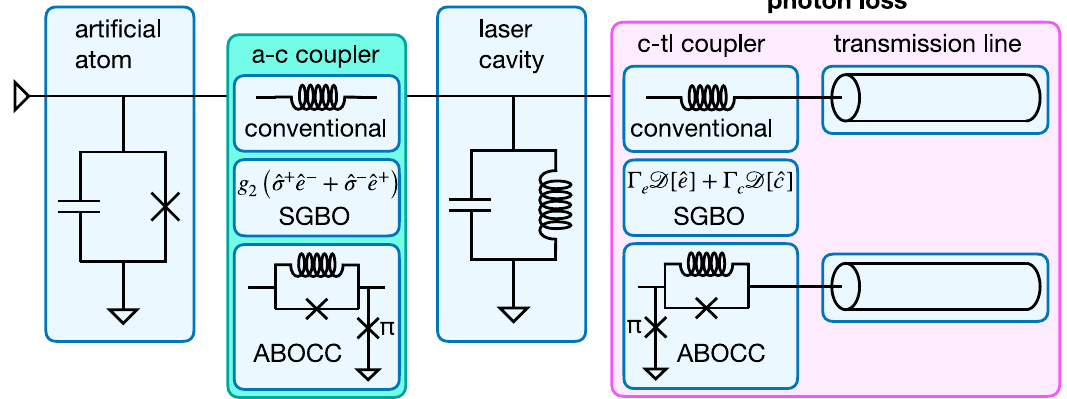
Fig. 1 Schematic of the superconducting Josephson laser. The laser is composed of: an arti fi cial two-level atom (transmon qubit) that is incoherently pumped from the ground to the excited state at the rate Γ p , an atom-cavity (a-c) coupling circuit, a laser cavity made of an LC resonator, a cavity- transmission line (c-tl) coupling circuit, and an output transmission line. The coupling circuits come in three fl avors: (1) conventional: linear inductors, (2) Susskind – Glogower bare operator (SGBO) couplers, and (3) Approximate Bare Operator Coupling Circuits (ABOCC). As the SGBO scheme is a purely theoretical construct, it is represented by the a-c coupling Hamiltonian and the photon loss